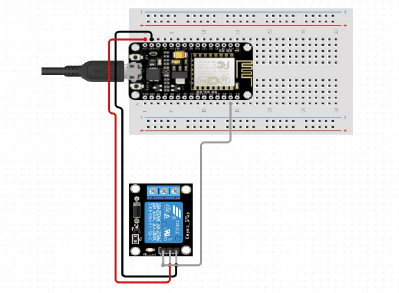
Figure 6. Relay Module Planning